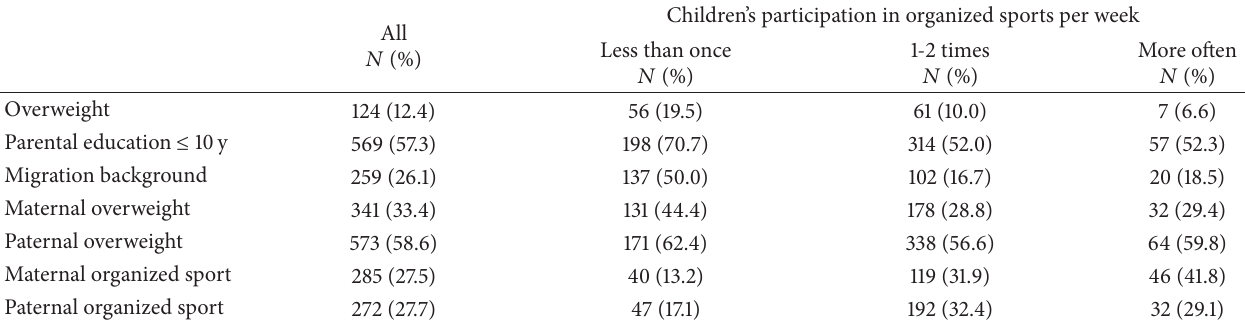
Table 2: Distribution of the occurrence of confounding variables of the total sample (all) stratified by participation in organized sports per week. Indicated are 𝑁 and %.